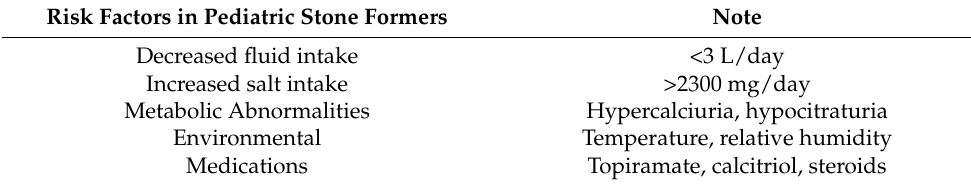
Table 1. Risk factors for pediatric stone forming